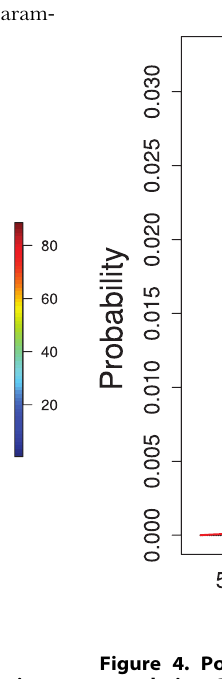
Figure 3. Map of predicted mean density of individuals in a simulated population. Activity centers of individuals are superim- posed on the map.